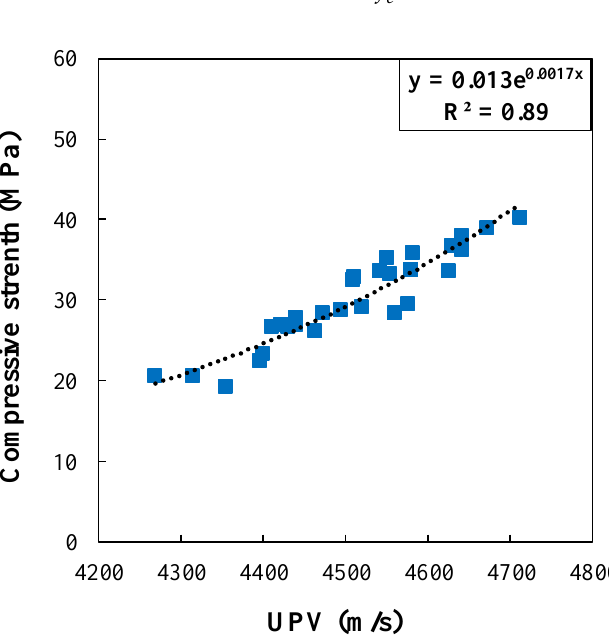
Figure 20. Experimental relationship between compressive strength and UPV together with test data for all concrete specimens .